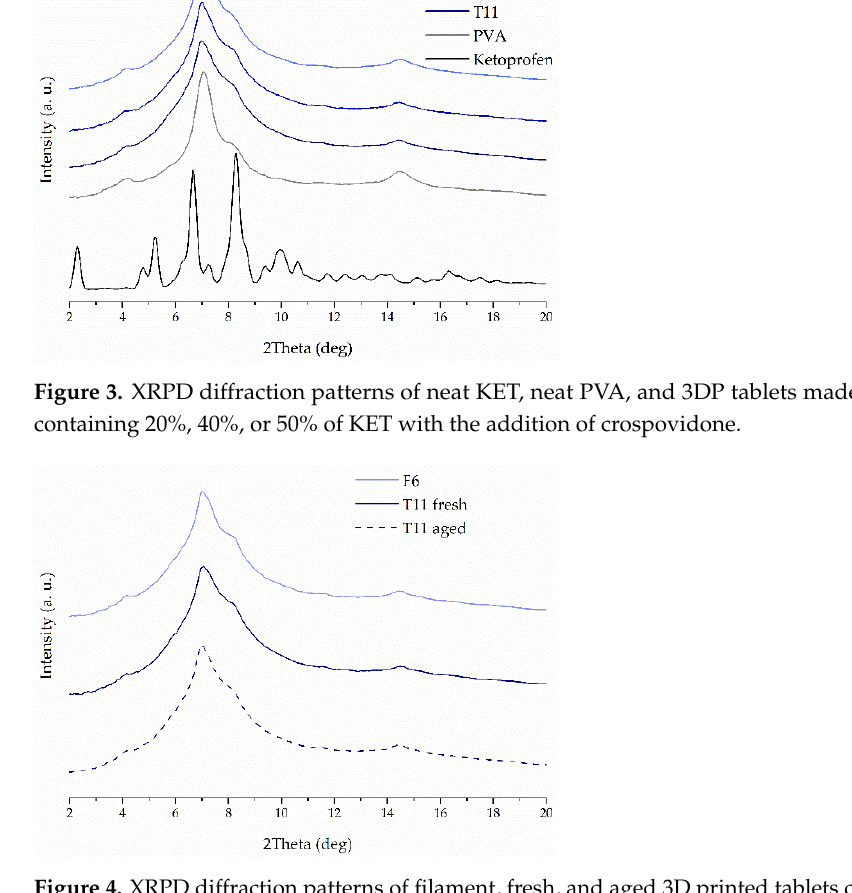
Figure 4. XRPD diffraction patterns of filament, fresh, and aged 3D printed tablets composed of 50% KET, crospovidone, and PVA.